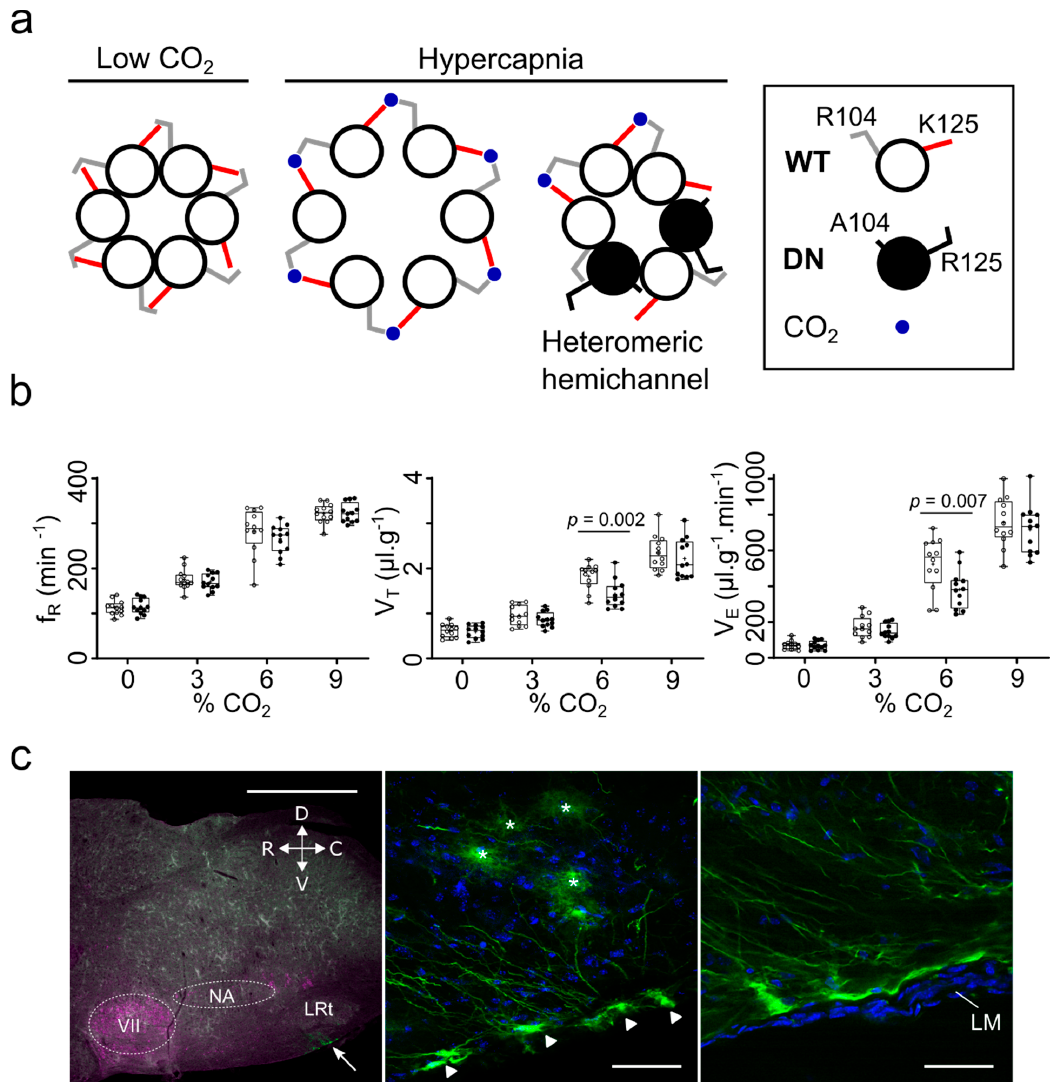
Figure 1. The contribution of Cx26 to the chemosensory control of breathing. ( a ) The concept of the dominant negative Cx26 subunit (Cx26 DN ) which carries the mutations R104A and K125R. Coassembly of Cx26 WT and Cx26 DN into heteromeric hemichannels will be insensitive to CO 2 because insufficient carbamate bridge formation will occur to induce channel opening. ( b ) Expression of Cx26 WT (open circles) and Cx26 DN (filled circles) under control of GFAP promoter in the caudal parapyramidal area reduces the response to hypercapnia. Both the hypercapnia-induced increases in tidal volume (V T ) and minute ventilation (V E ) are reduced by Cx26 DN expression. Cx26 DN expression has no effect on the respiratory frequency (f R ). ( c ) Location of transduced cells. Left image: cholinergic cells stained with anti-ChAT; the white arrow points to superficial transduced glial cells ventral to the lateral reticular nucleus (LRt); scale bar 1 mm. The centre and right images show these cells at higher power (scale bars 50 µ m). Asterisks indicate astrocytes, triangles the superficial somata of the chemosensory glial cells. VII—facial nucleus; NA—nucleus ambiguous; LM—leptomeningeal layer. Adapted from